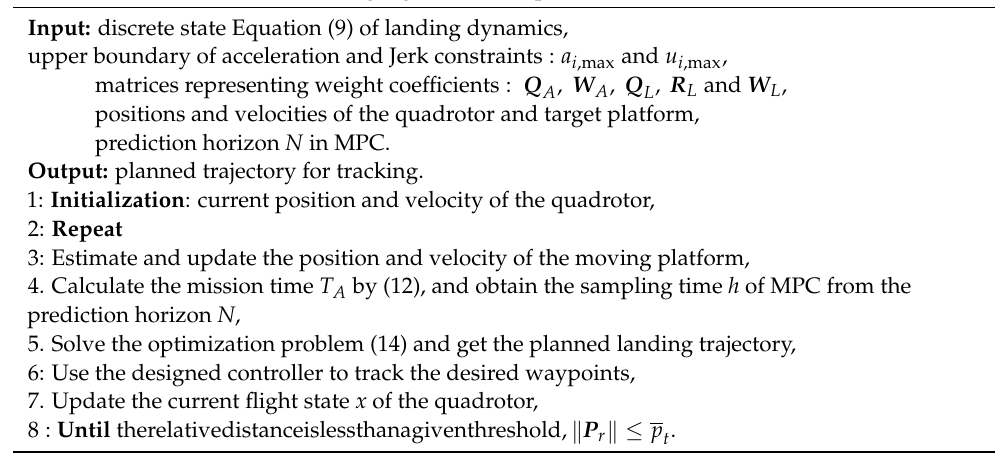
Algorithm 1. Autonomous landing algorithm of a quadrotor via MPC